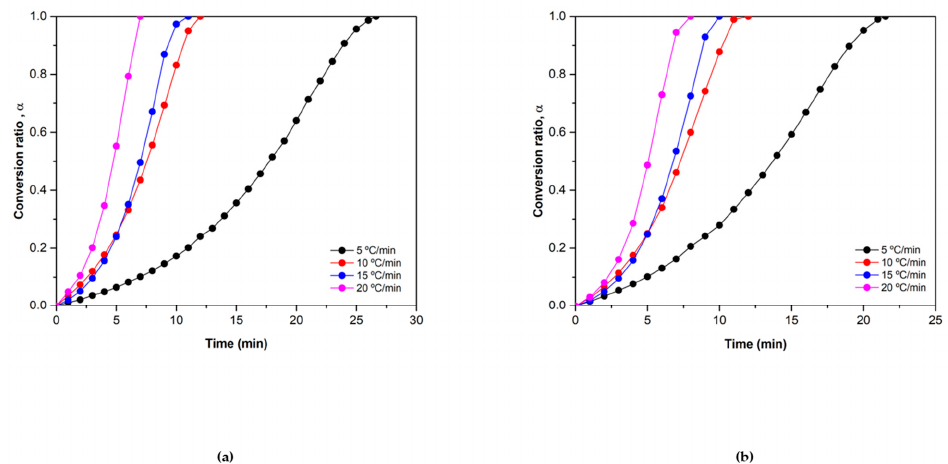
Figure 2. α vs. time plots of the reduction reaction of ( a ) Co 2.4 Ni 0.6 O 4 and ( b ) 0.5% SiO 2 /Co 2.4 Ni 0.6 O 4 .